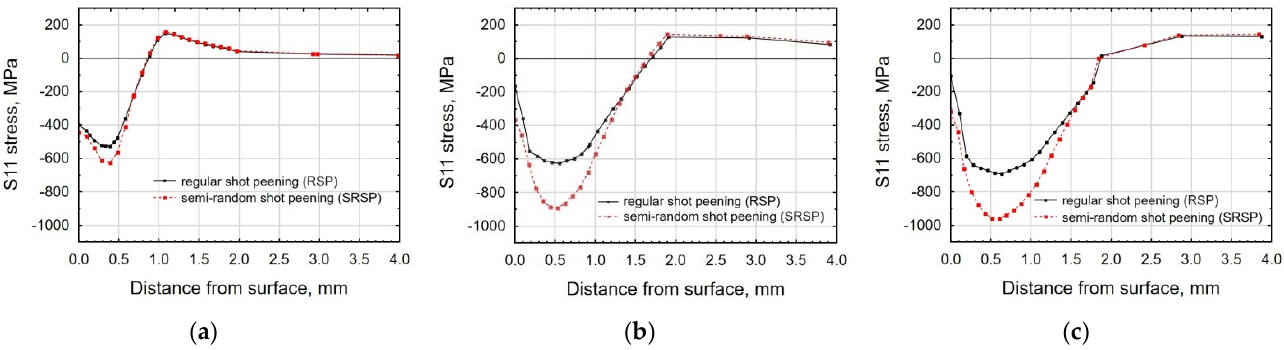
Figure 19. Comparison of the S11 stress distribution for RSP and SRSP as a function of distance from the surface for different impact energies: ( a ) E = 15 mJ, ( b ) E = 100 mJ, ( c ) x = 185 mJ.